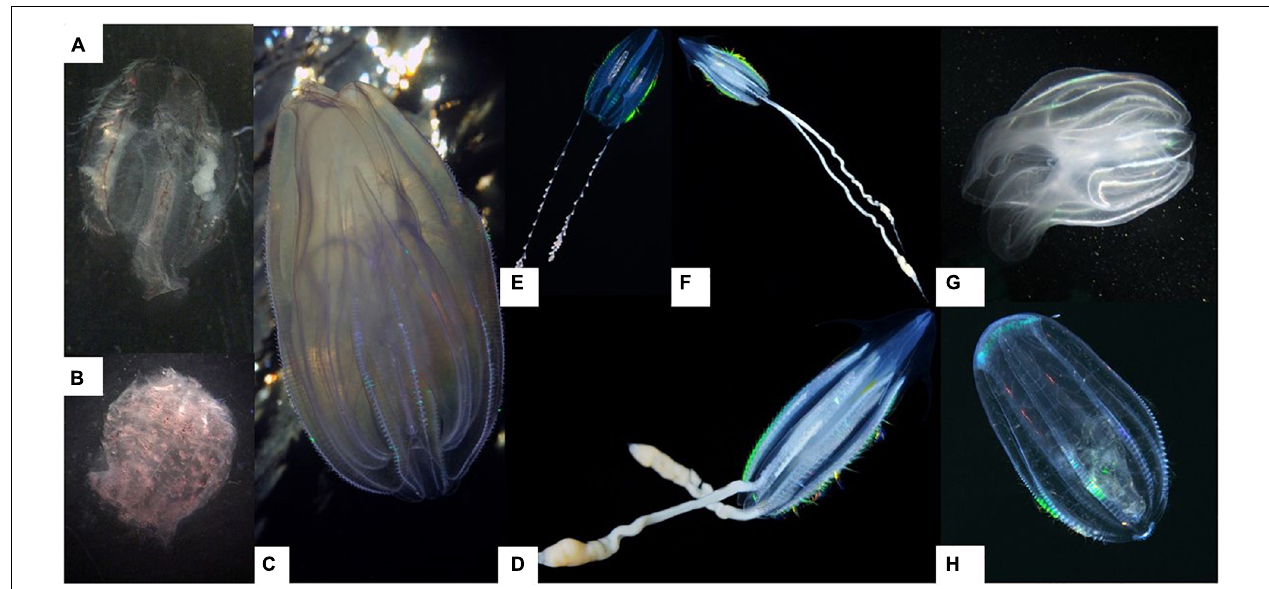
FIGURE 2 | Ctenophore taxa identified along the Norwegian coast from Skagerrak to Svalbard: Typical example of net collected ctenophores (A) Mertensia ovum and (B) Beroe sp.; underwater images received from the citizen science participants (C) Bolinopsidae sp., (E) Euplokamis cf. dunlapae , (D,F) Undescribed cydippid ctenophore (same specimen), (G) Lobata spp. and (H) Beroe cucumis. Photos: (A,B) Sanna Majaneva, ( C–F,H) Nils Aukan and (G) Vigdis